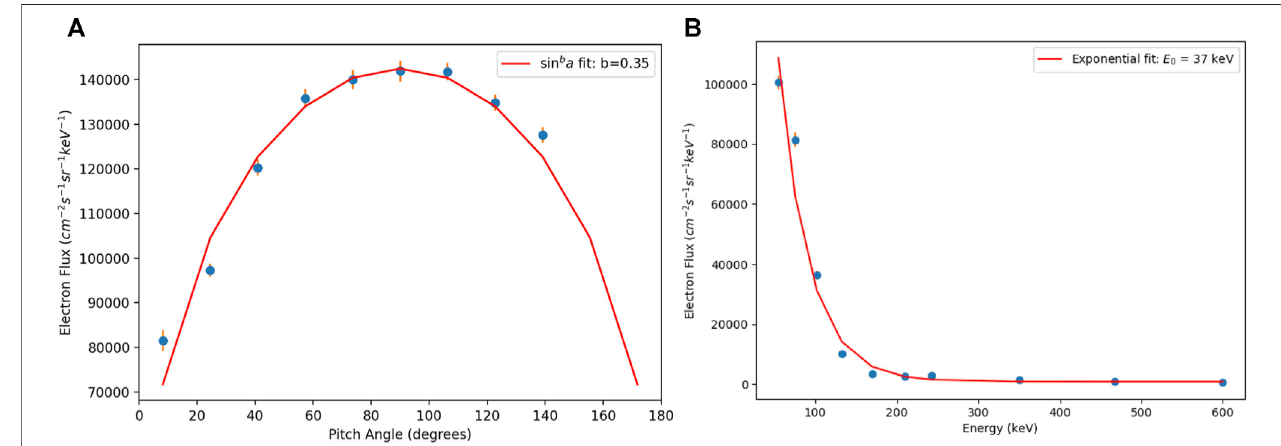
FIGURE 4 | Example pitch angle (A) and energy (B) distributions from the RBSP-B MagEIS instrument with superposed fi ts. The pitch angle distribution is shown for ∼ 75 keV electrons and the energy distribution is shown near the loss cone at α ∼ 8 ° .